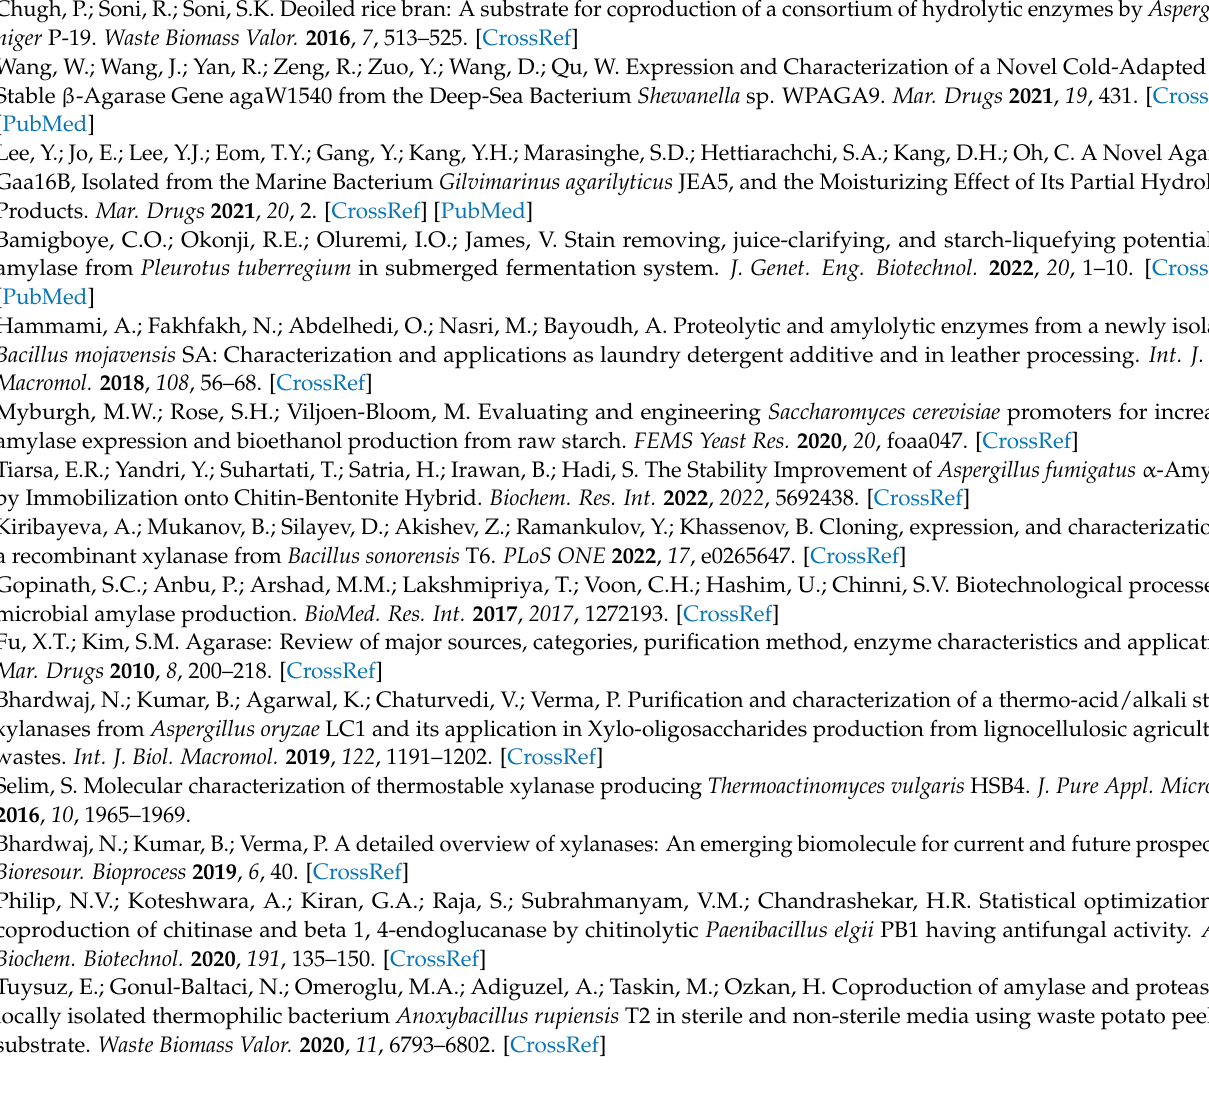
agar; Table S2: Composition of nutrient agar; Figure S1: Phylogenetic tree of the isolated organism; Figure S2: Enzyme activities in basic nutrient broth with respect to